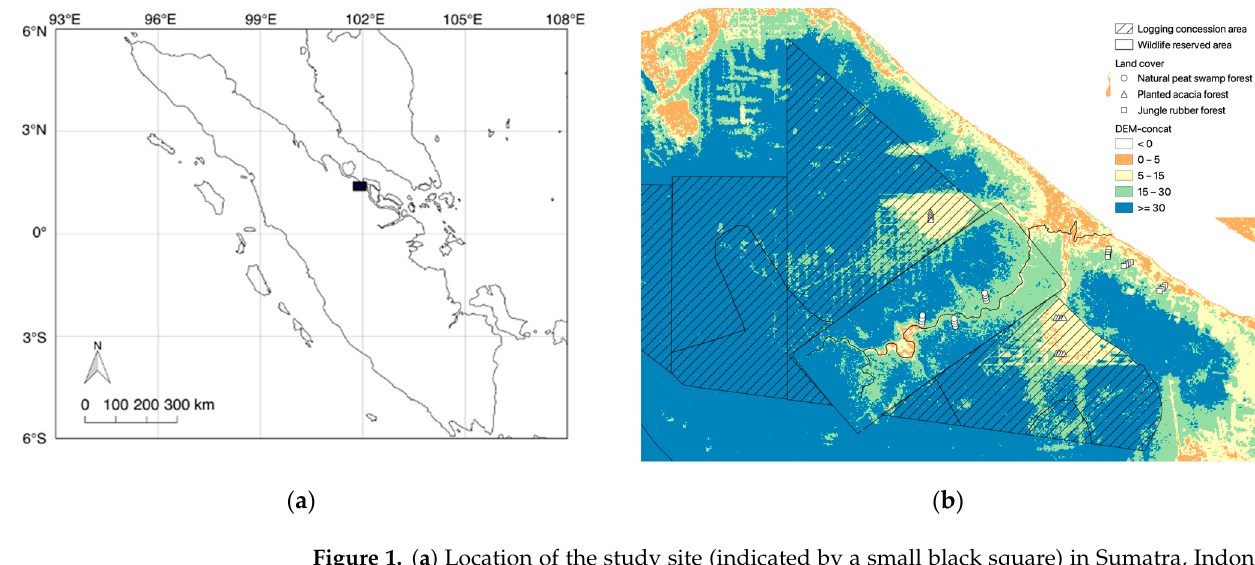
Figure 1. ( a ) Location of the study site (indicated by a small black square) in Sumatra, Indonesia. ( b ) Location of survey transects: natural peat swamp forests (NPF) shown by circles, planted acacia forests (PAF) by triangles, and jungle rubber forests (JRF) by rectangles. Bukit Batu Wildlife Reserve is shown in a rectangle along the Bukit Batu River. Acacia plantations are shown in the area with diagonal lines, where logging operation is permitted and managed by plantation companies named PT Bukit Batu Hutani Alam and PT Sakato Paratama Makmuri.